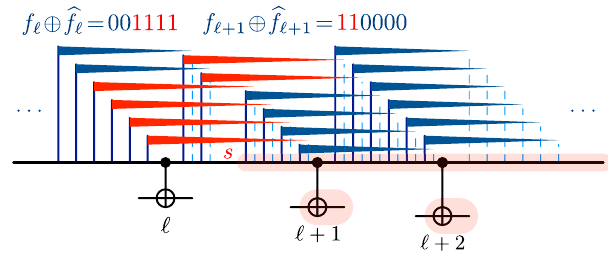
FIG. 5. If t = 3, s ∈ S flips six flags in f (cid:3) and f (cid:3) + 1 .